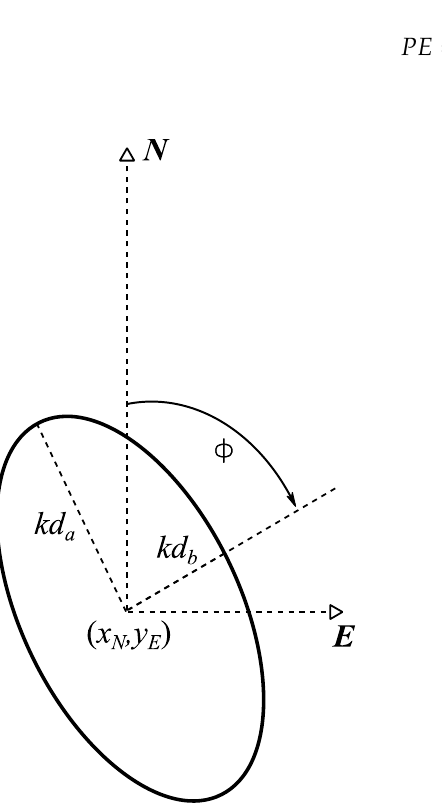
Figure 5. Elliptical representation of an SBAS based protection area (based on [31]).